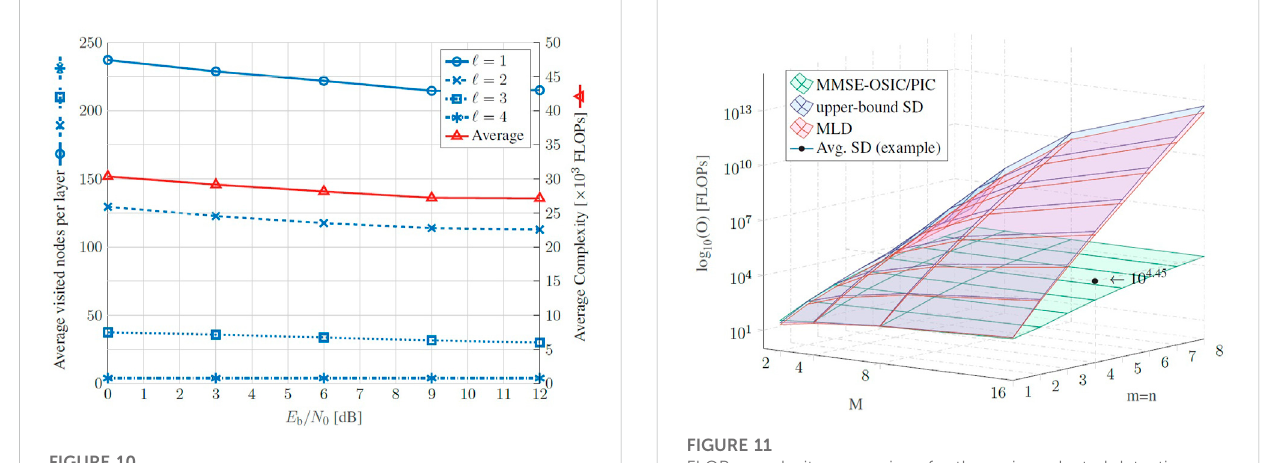
FIGURE 10 SD complexity analysis for the simulated parameters.